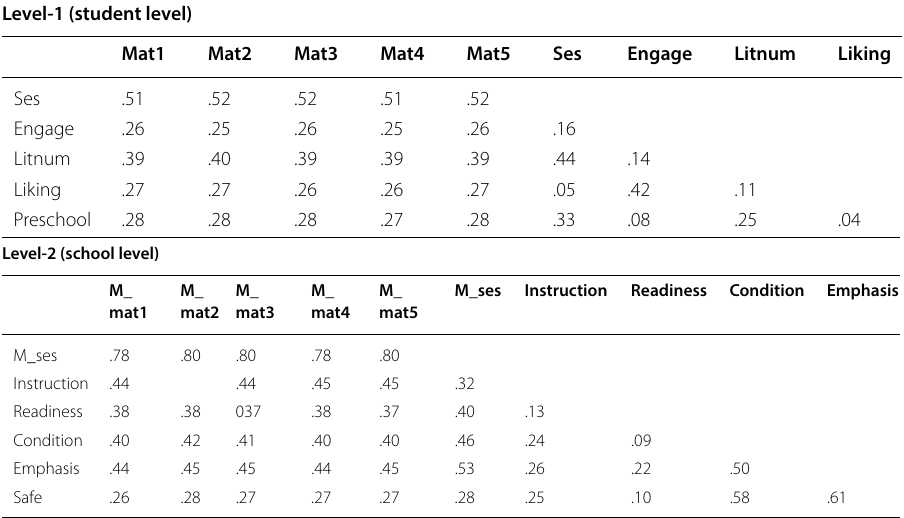
Table 4 Inter-item correlations at student and school levels Level‑1 (student level) Mat1 Mat2 Mat3 Mat4 Mat5 Ses Engage Litnum Liking Ses .51 Engage Litnum Liking Preschool Level‑2 (school level) M_ mat1 Instruction .44 Readiness .38 Condition Emphasis Safe